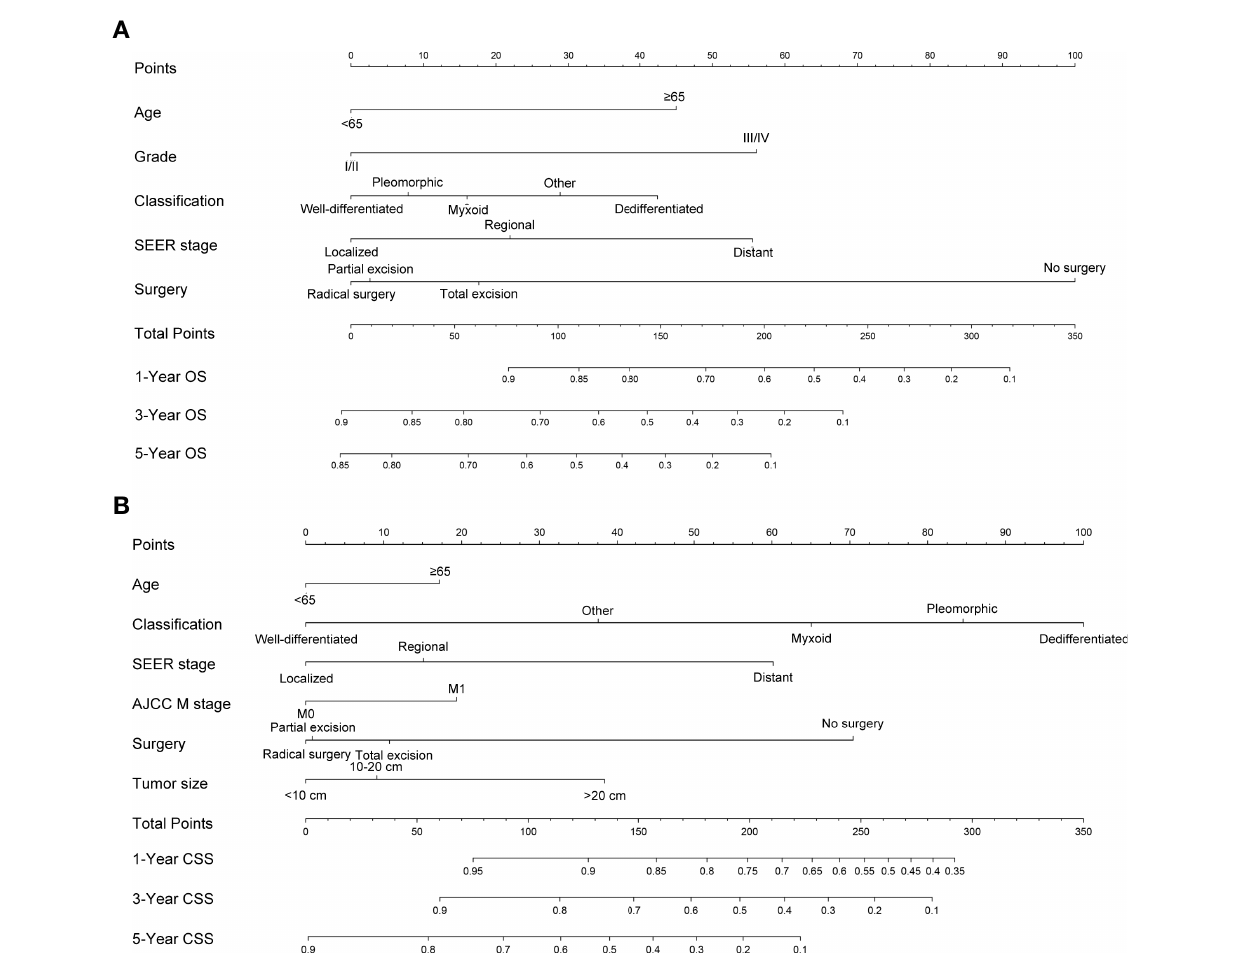
FIGURE 1 | Nomogram predicting 1-, 3-, and 5-year (A) OS, (B) and CSS of patients with RPLs. Summarizing the scores of each variable together and the total points projected on the bottom scales indicate the probabilities of 1-, 3-, and 5-year OS and CSS. OS, overall survival; CSS, cancer-speci fi c survival; RPLs, retroperitoneal